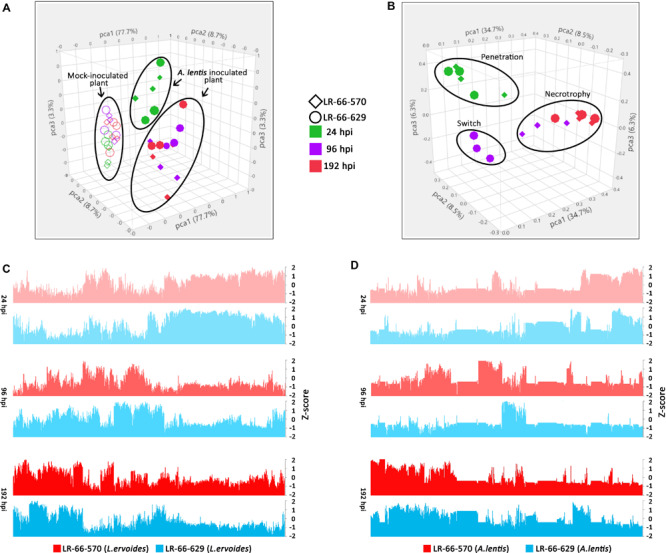
Overview of transcriptome variability of Lens ervoides RILs LR-66-629 (resistant) and LR-66-570 (susceptible), and Ascochyta lentis samples at 24, 96 and 192 h post inoculation (hpi). Each point in the PCA plot represents an individual sample. (A) PCA clustering of host samples. Mock-inoculated samples are indicated by open symbols and A. lentis-inoculated samples are depicted by solid symbols. (B) PCA clustering of pathogen samples. Samples collected at 24 (green), 96 (purple) and 192 (red) hpi from LR-66-570 (circle) and LR-66-629 (diamond) were used for analysis. (C) Overview of gene expression for L. ervoides samples. (D) Overview of gene expression for A. lentis on two L. ervoides hosts. The normalized value (Z-score) was used to describe the gene expression for each sample at 24, 96, and 192 hpi.